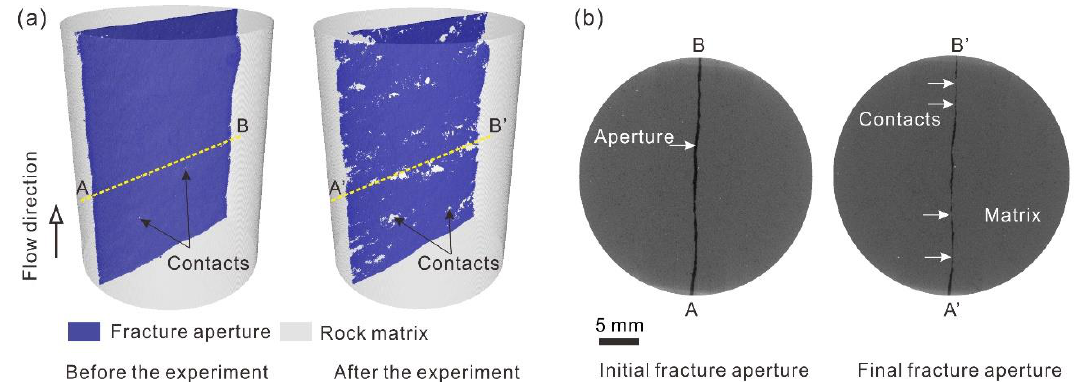
Figure 8. ( a ) Three-dimensional (3-D) models of the fractured sample core before (left) and after (right) the flow-through experiment as obtained from the X-ray µ CT scans. The fracture void (in blue) was extracted from the reconstructed 3-D models. ( b ) Images of the cross-sections AB and A’B’, with their locations in the core shown in (a), taken perpendicular to the long sample axis before (left) and after (right) the flow-through experiment.